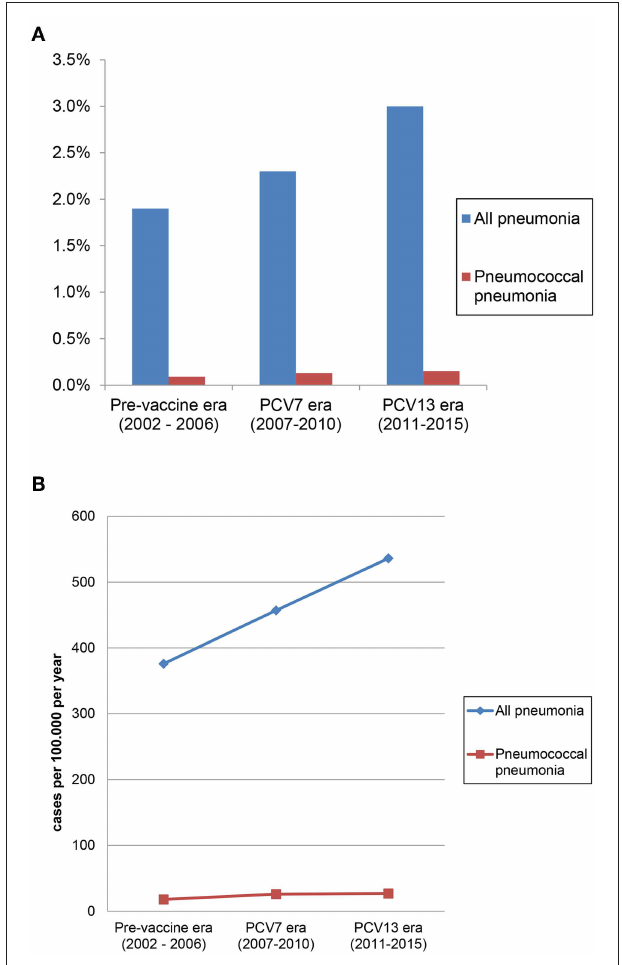
FIGURE 4 | (A) Proportion of hospitalizations with pneumonia and pneumococcal pneumonia (among all hospitalizations). (B) Incidence of hospitalizations with pneumonia and pneumococcal